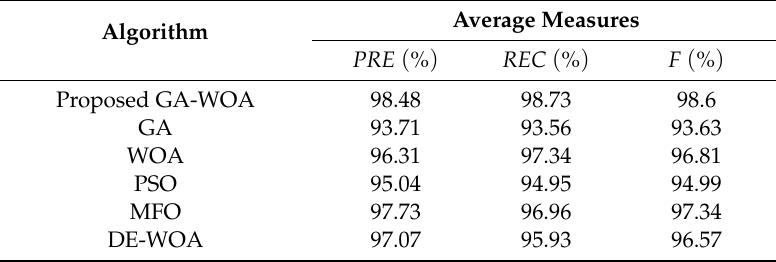
Table 5. Average measures for each algorithm across all datasets (detailed results of algorithms can be followed in Tables A1–A6 of the Appendix